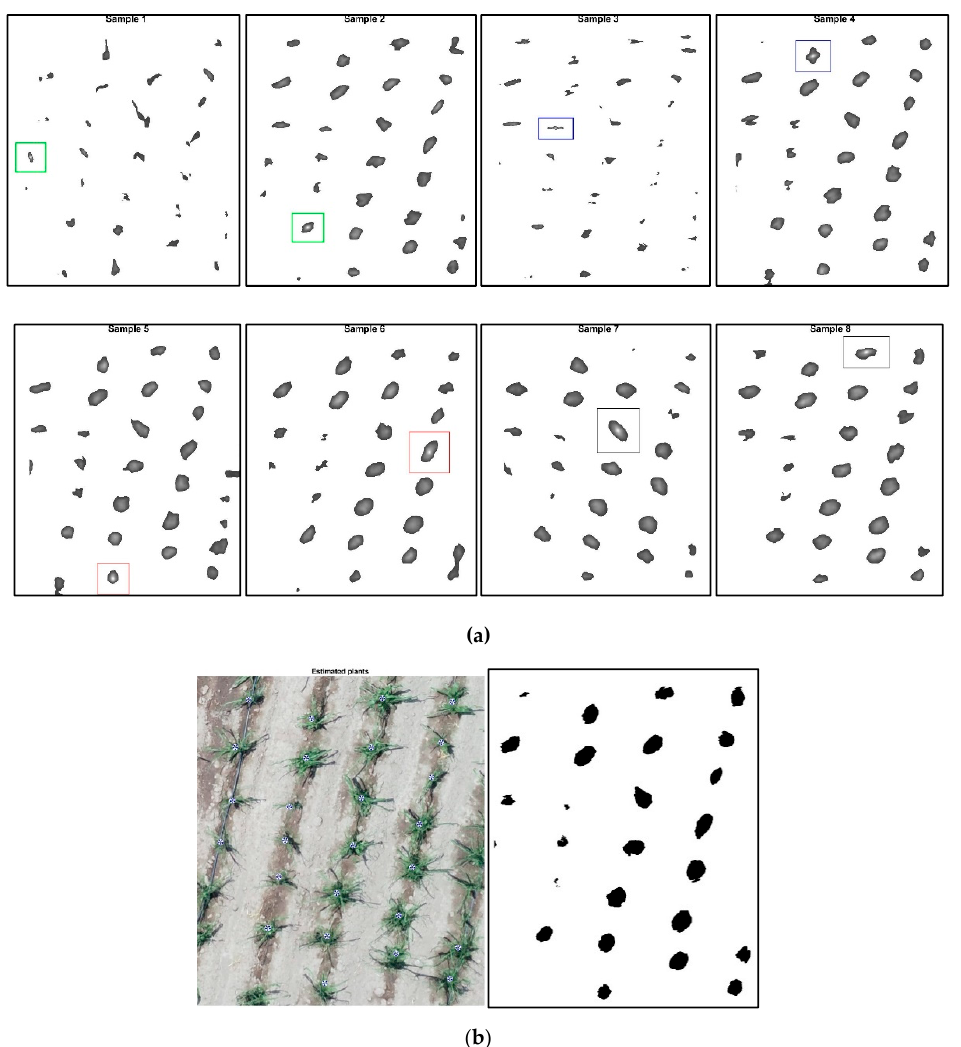
Figure 4. ( a ) Binary images of the normalized cross-correlation of eight samples with respect to the image; ( b ) image resulting from the mean correlation of eight samples.